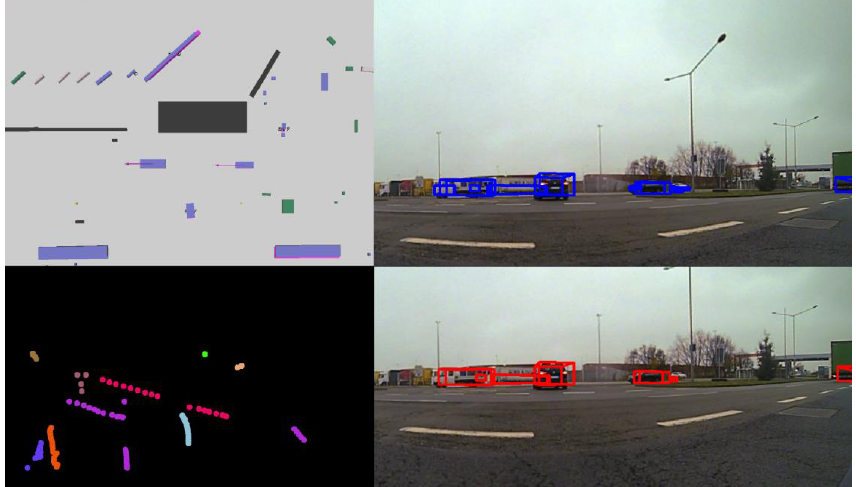
Figure 11. Tracking of dynamic and static objects. In the top-left corner, the birds-eye view 3D image of the scene can be observed. In the top-right corner, the 3D object detections are projected over the color image in blue. In the bottom-right image, the tracks corresponding to the detections are shown in red. In the bottom-left image, the traces of the tracked objects are shown in the same color for the same object instance.